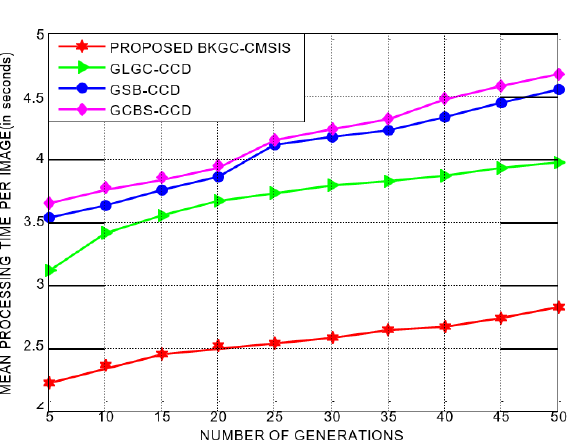
Figure 5. Specificity of the proposed BKGC-CMSIS scheme